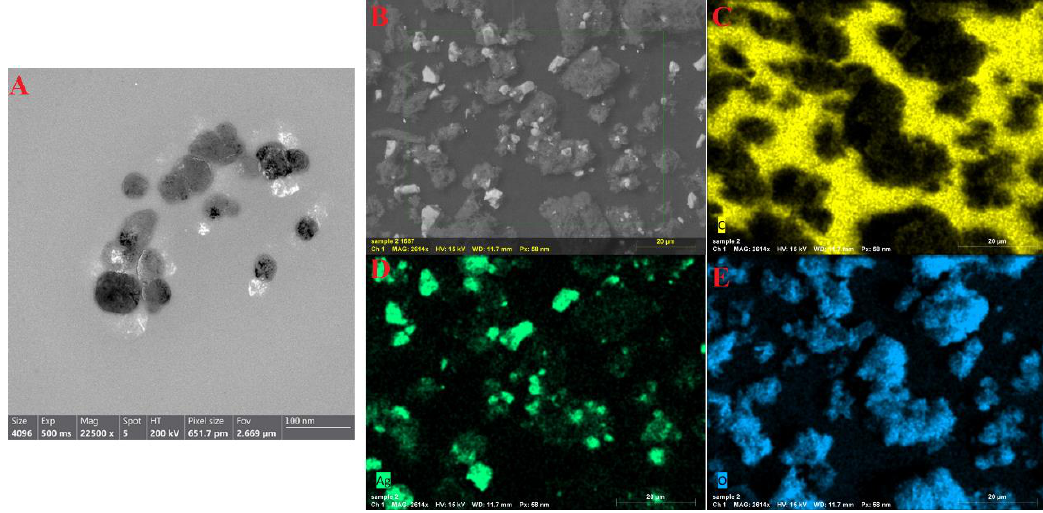
Figure 2. TEM image ( A ), SEM image ( B ), and SEM/EDX mapping analysis ( C – E ) of